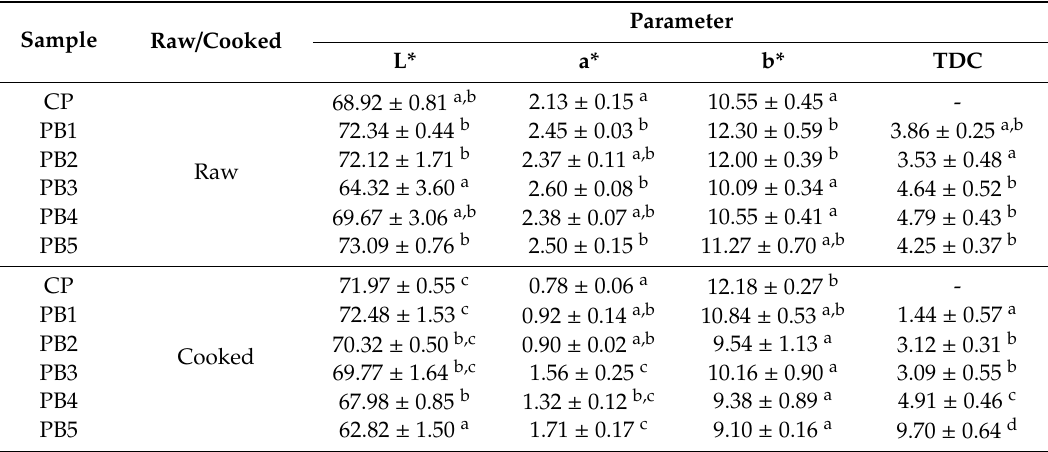
Table 2. Colour parameters of raw and cooked pasta.